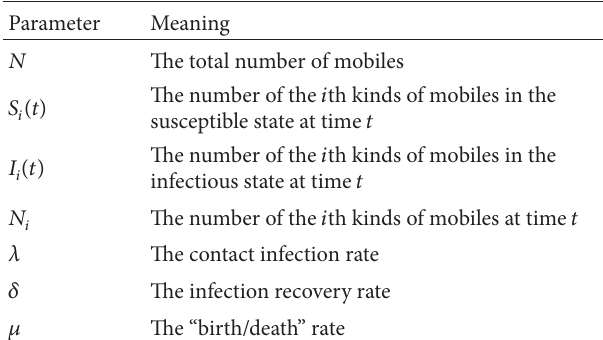
Table 1: Parameters description in the M-SIS